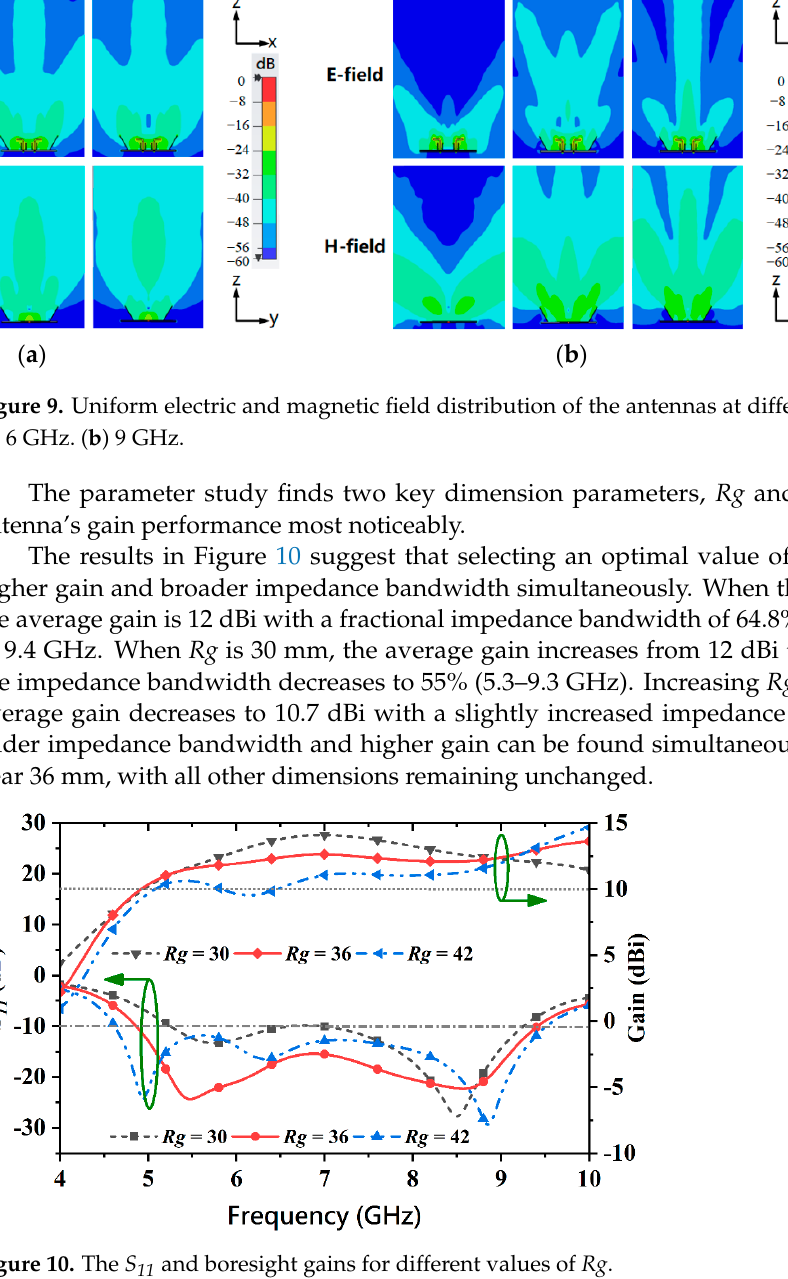
Figure 10. The S 11 and boresight gains for different values of Rg.